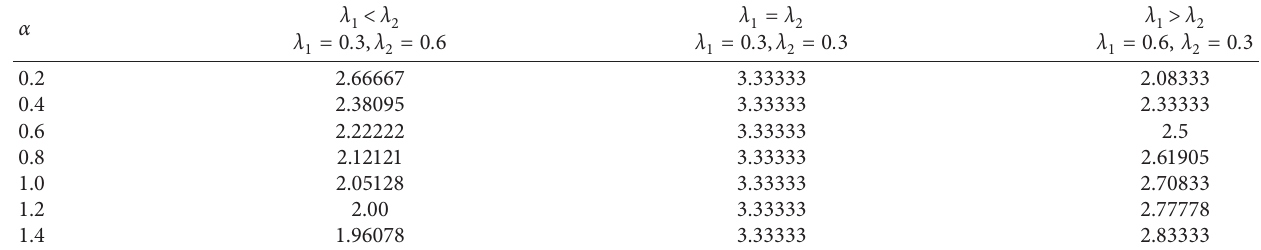
Figure 5: System reliability versus failure rate λ Table 1: The mean time to system failure (MTTF) for different values of α .